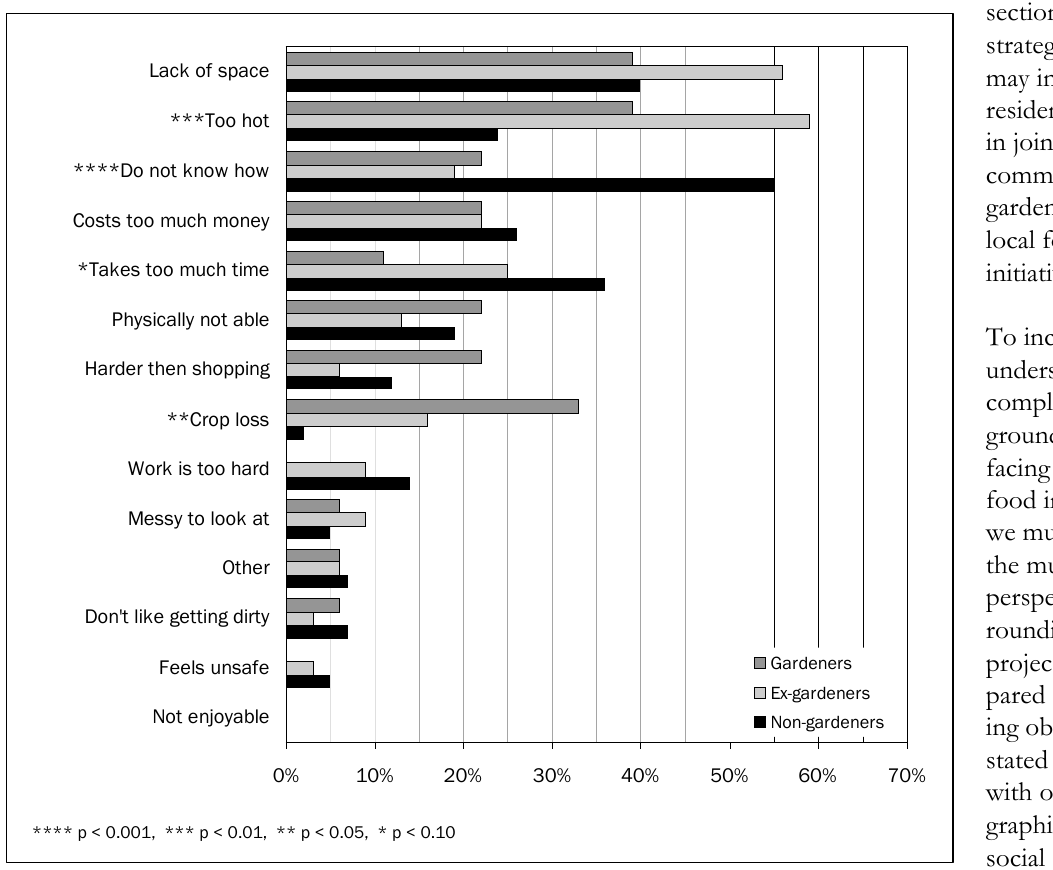
Figure 2. Percent of Respondents by Gardening Status Who Identified the Item as an Important Burden of Gardening